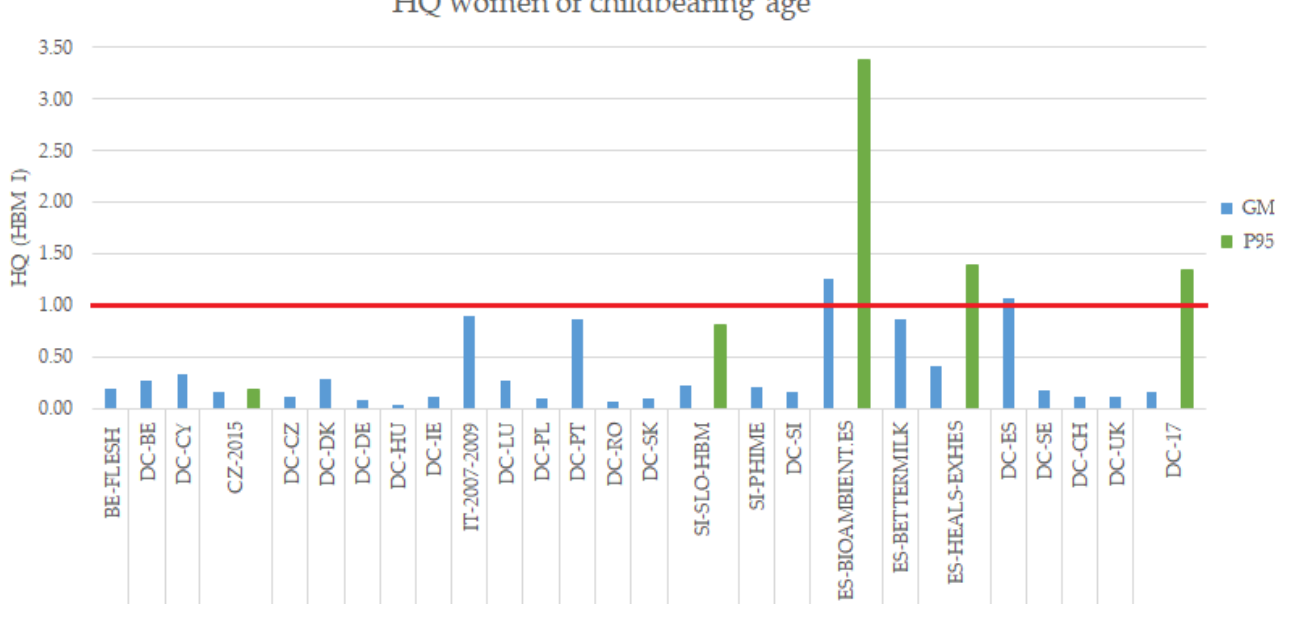
Figure 3. HQ for the GM and P95 of Hg blood levels of the HBM European studies in women of childbearing age (18–50 years old). DEMOCOPHES Study (DC). Note: MeHg levels in the case of FLESH and Valent et al., 2013 studies.